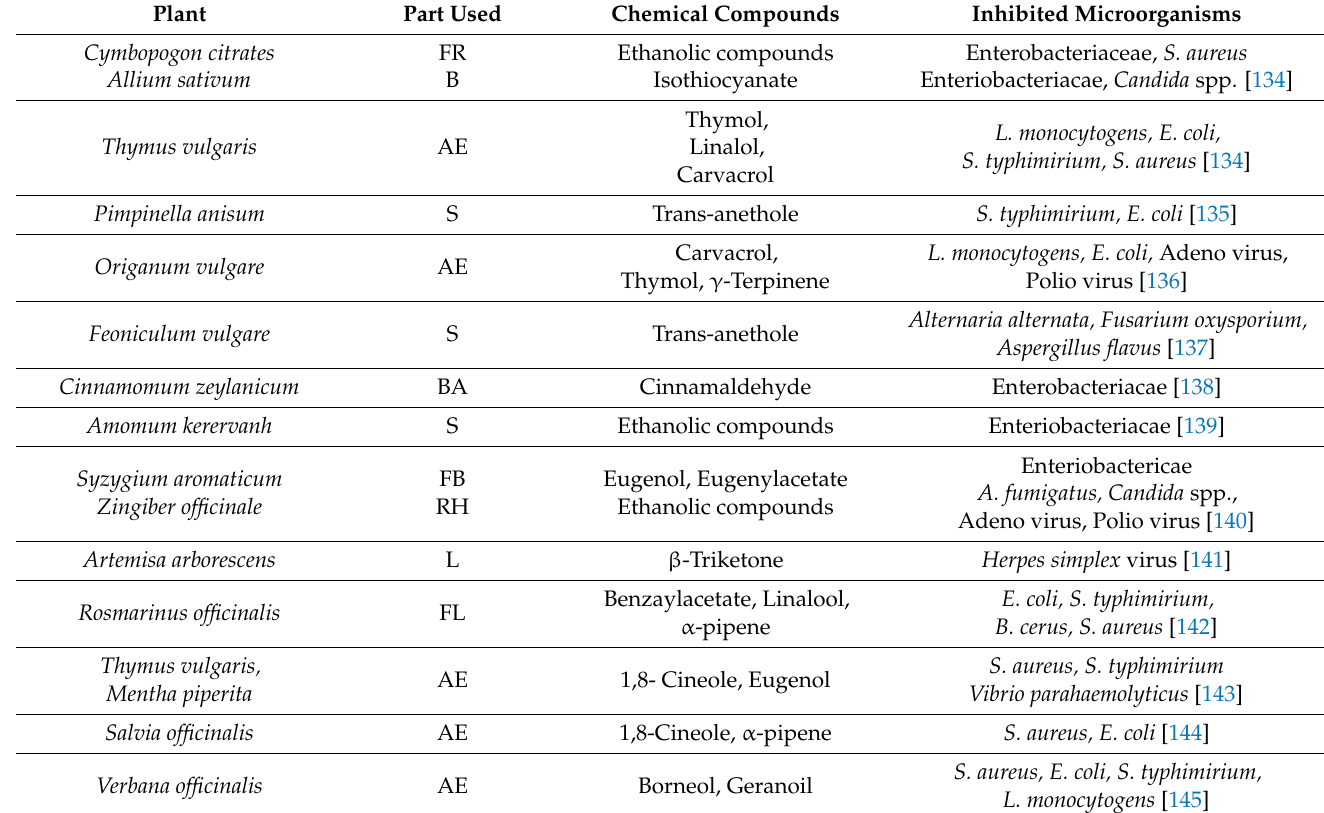
Table 2. Effect of essential oil on the pathogenic microorganisms [133]. Plant Part Used Chemical